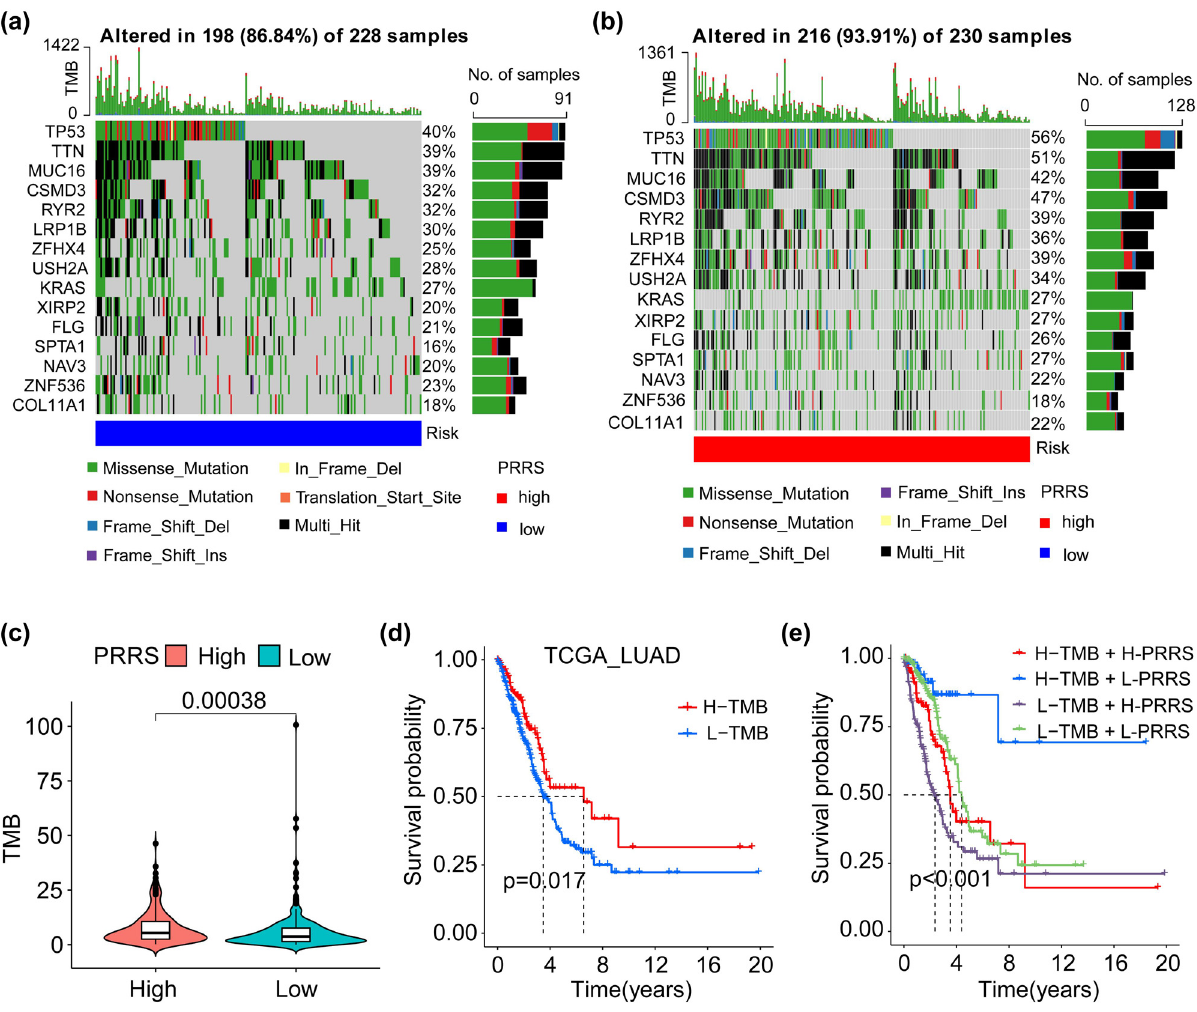
Figure 6: Mutation signatures of PRRS - based LUAD patients. ( a and b ) Waterfall plots of mutation genes in L - PRRS ( a ) and H - PRRS ( b ) subgroups from the TCGA_LUAD cohort. ( c ) TMB of the H - PRRS group was signi fi cantly higher than the L - PRRS group. ( d ) In the TCGA_LUAD cohorts, patients in the H - TMB groups had a longer OS than the L - TMB group. ( e ) In the TCGA_LUAD cohorts, patients in the H - TMB + L - PRRS group had the best prognosis. L - TMB: low TMB; H - TMB: high TMB; L - PRRS: low PRRS; H - PRRS: high